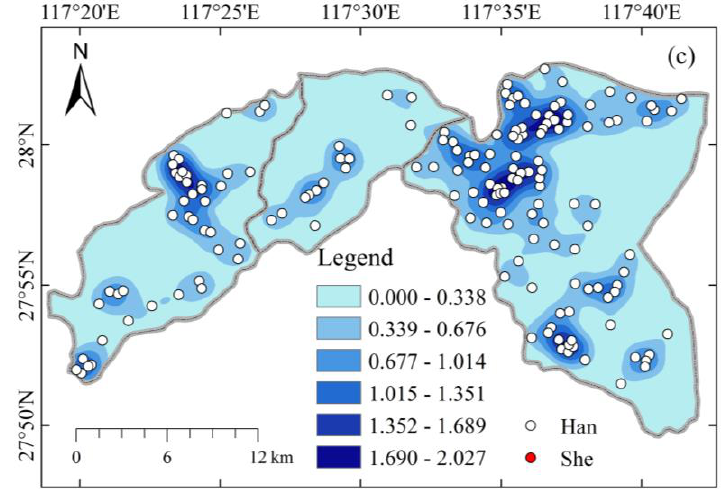
Figure 7. Kernel density estimation map of human settlements. ( a ) The spatial distribution of all settlements; ( b ) the spatial distribution of She settlements; ( c ) the spatial distribution of Han settle- ments.